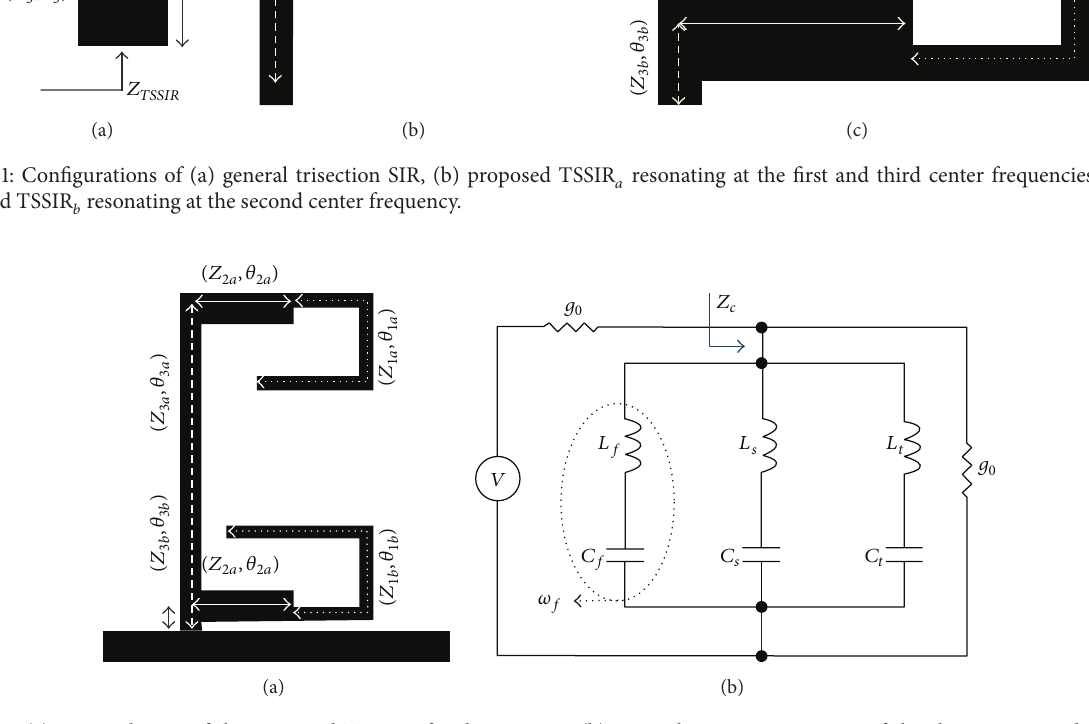
Figure 2: (a) Design layout of the proposed TBBSF of order, 𝑁 = 1 . (b) Equivalent circuit in terms of the shunt-connected series 𝐿𝐶